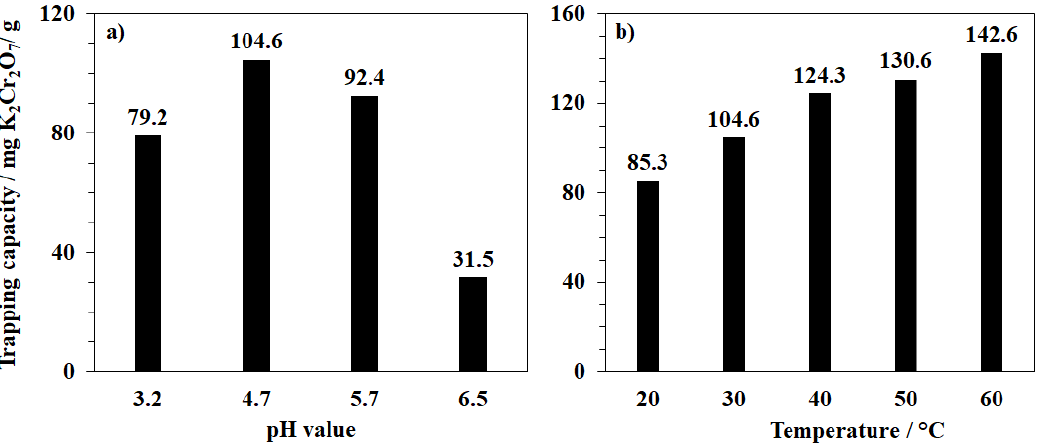
Figure 7. Effect of pH ( a ) and temperature ( b ) on K 2 Cr 2 O 7 trapping capacity of MOF-808_300.